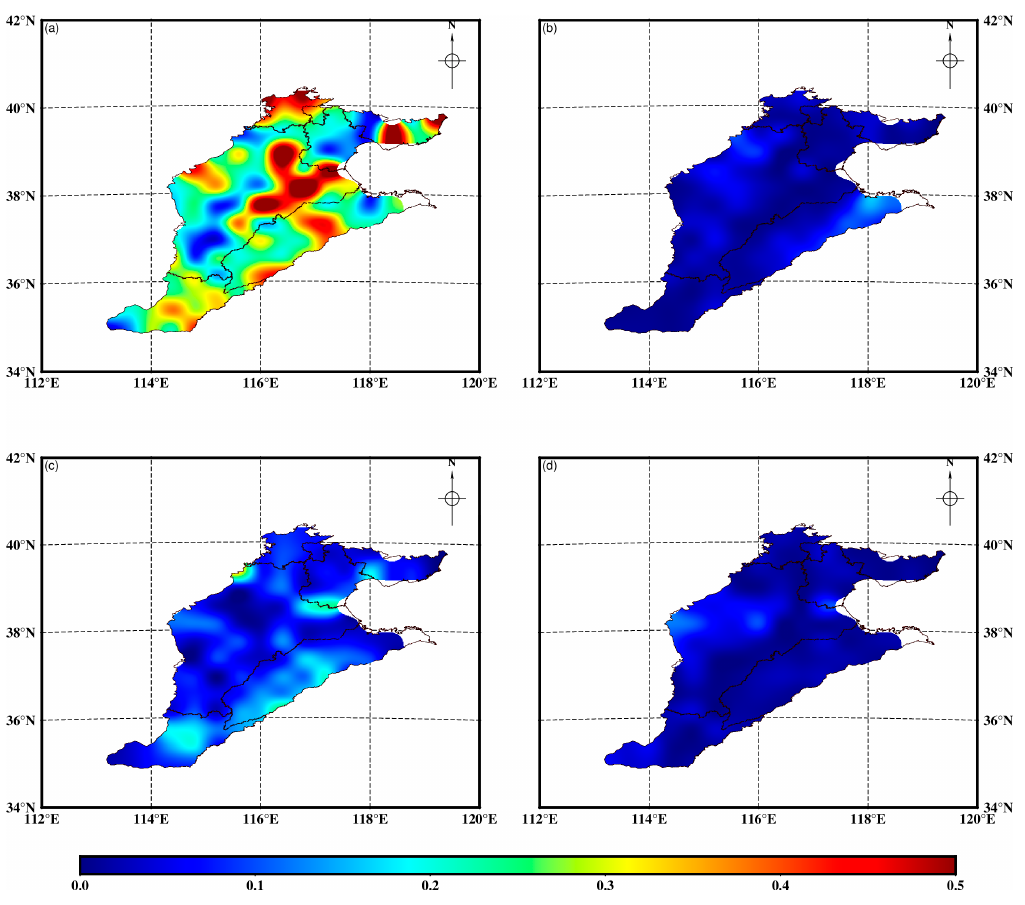
Figure 7. The spatial pattern of proportional reduction of error (ProRE) for regression model predictors. ( a ) for non-climatic part; ( b ) for one-month precipitation part; ( c ) for four-month precipitation part; ( d ) for twelve-month precipitation part.